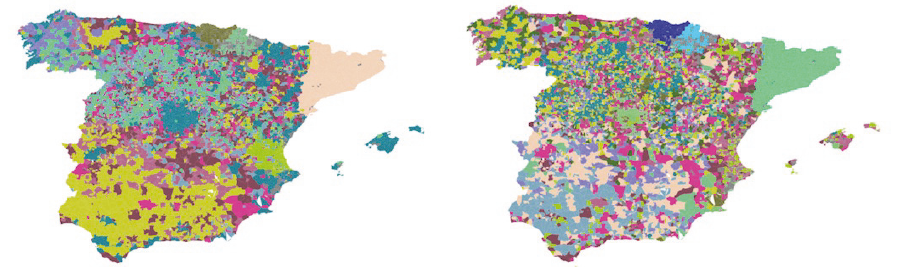
Figure 6: First-level communities obtained via community detection algorithm Infomap, performed on the thresholded, undirected, and weighted network based on the similarity matrix S (see the text). Here we color nodes belonging to the same community in the same color. There is an appreciable matching between functional network communities in the network of municipalities and actual Spanish autonomous communities, although this correspondence is much more evident for the 2015 round, where bipartisanship breakdown was at its